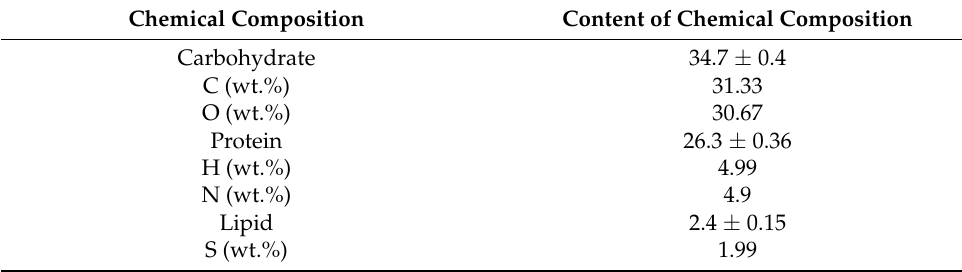
Table 3. Chemical composition of C. glomerata